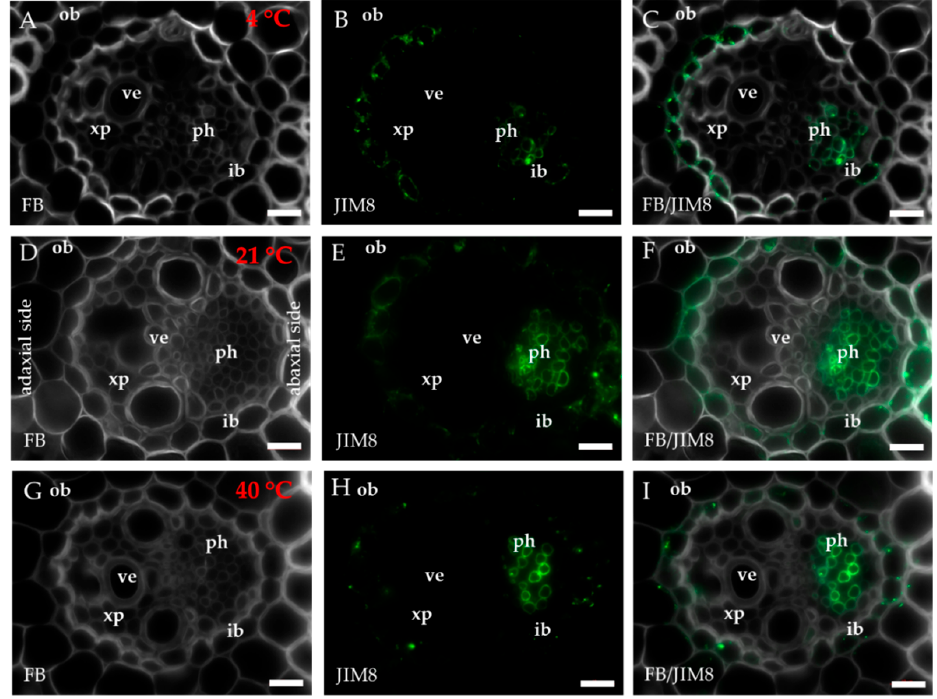
Figure 2. Immunolocalisation of the JIM8 epitope ( A – I ) in cross ‐ sections of the B. distachyon leaves, ( A – I ): through the major vascular bundle. ( A – C ): 4 °C; ( D – F ): 21 °C; ( G – I ): 40 °C. Abbreviations: FB— fluorescent brightener, ib—inner bundle sheath, ob—outer bundle sheath, ph—phloem, ve—vessels, xp—xylem parenchyma. The green colour shows epitope occurrence. Scale bars: 10 μ m.